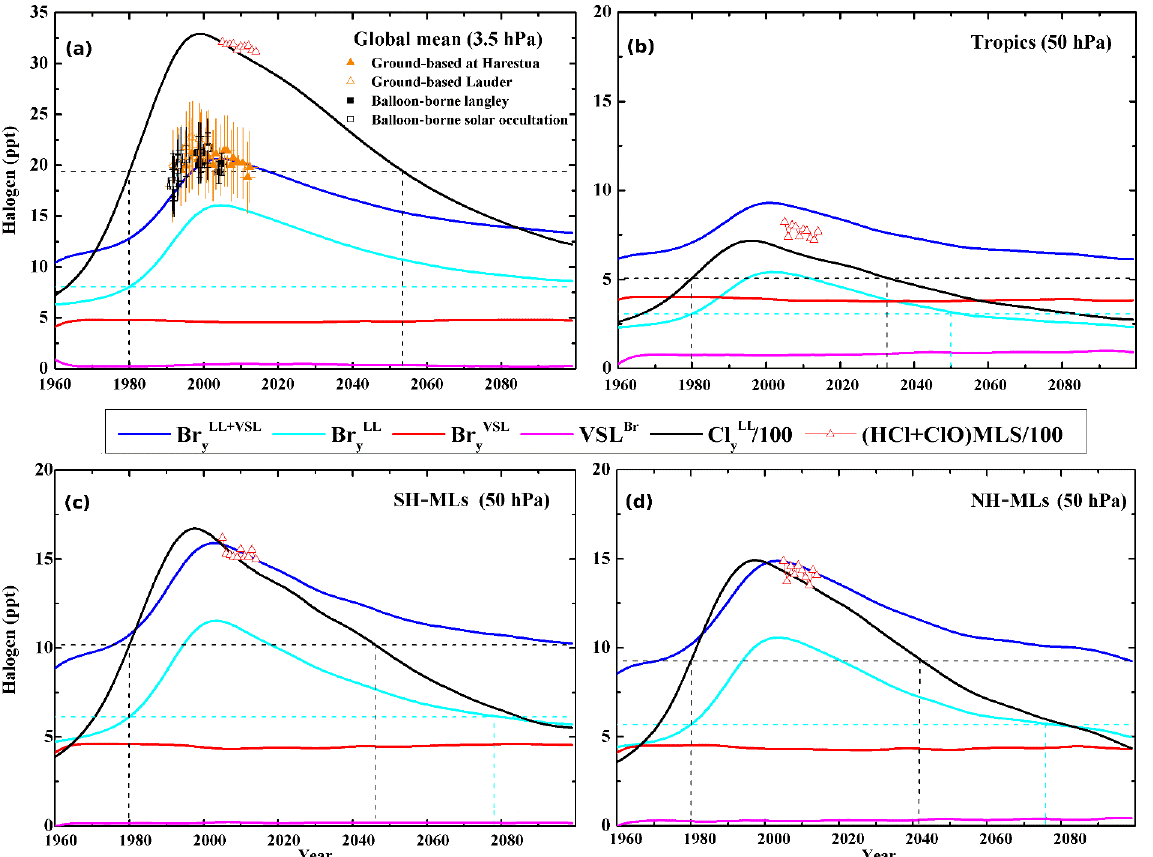
Figure 1. Temporal evolution (1960–2100) of the modelled annual mean abundances of VSL Br and inorganic halogen (Cl LL y and Br LL + VSL y ): (a) global upper stratosphere (3.5hPa); lower stratosphere (50hPa) in the (b) tropics and at (c) SH-MLs and (d) NH-MLs. The Br LL + VSL y abundance was split into long-lived (Br LL y ) and very short-lived (Br VSL y ) contributions. The black squares (filled and open) and orange triangles (filled and open) of panel (a) show the total stratospheric Br y trends from 1991 to 2012 (WMO, 2014, 2018). The red triangles show the mean annual mixing ratios (HCl + ClO) from the Microwave Limb Sounder (MLS) data (Waters et al., 2006; Livesey et al., 2018) from 2005 to 2015. The dashed horizontal lines indicate the modelled Cl LL y and Br LL y abundances for 1980. Note that both Cl LL y values and (HCl + ClO) MLS data were divided by